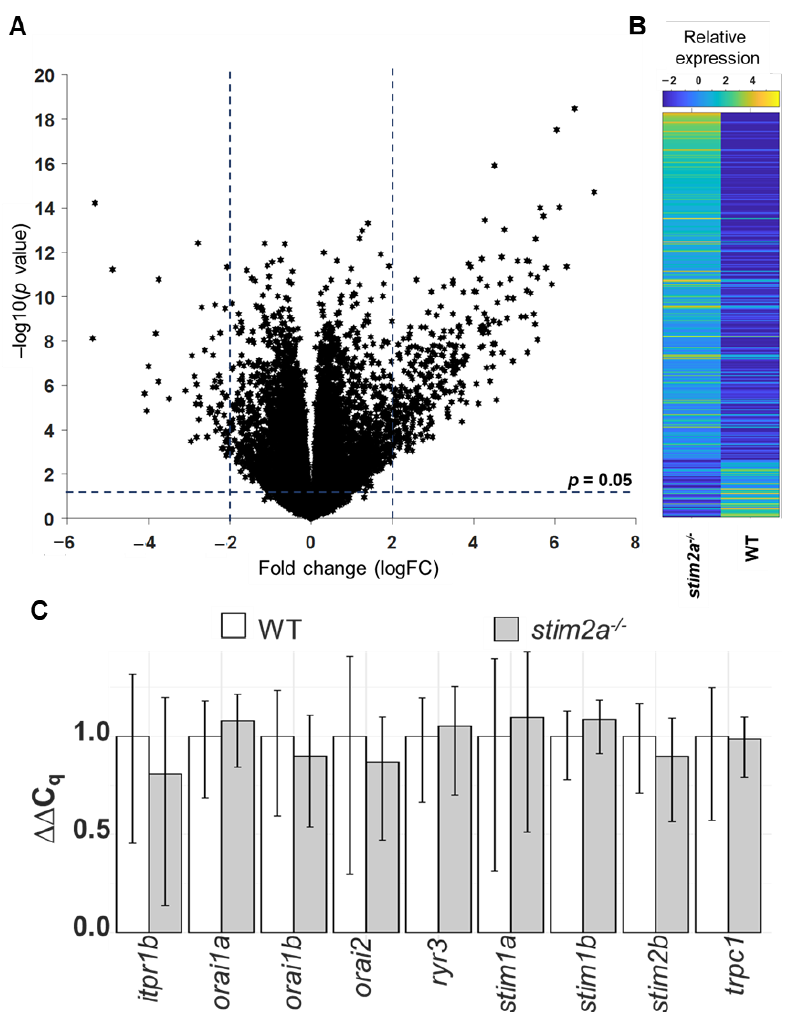
Figure 9. RNA sequencing analysis. ( A ) Volcano plot of the transcriptional di ff erences between the stim2a − / − and WT zebrafish larvae. The logarithms of the fold changes in the individual genes ( x axis) are plotted against negative logarithms of their p -value to base 10 ( y axis). Positive log 2 (fold change) values represent the upregulation in stim2a − / − larvae compared with WT larvae, and negative log 2 (fold change) values represent downregulation. Points above the dotted line represent di ff erentially expressed genes in stim2a − / − larvae with p < 0.05 after correction for multiple testing. ( B ) Heat map of a total of 392 genes that were identified as being di ff erentially expressed (log 2 (fold change) ≥ 2) between the stim2a − / − and WT larvae, including 336 upregulated genes and 56 downregulated genes. ( C ) mRNA levels of store-operated calcium entry (SOCE) components in 5 dpf zebrafish, quantified by qPCR.